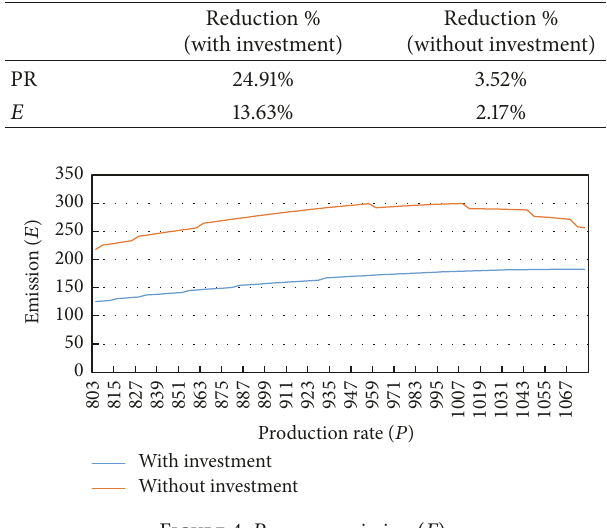
Table 5: Rates of reduction of PR and 𝐸 in emission minimization policy.